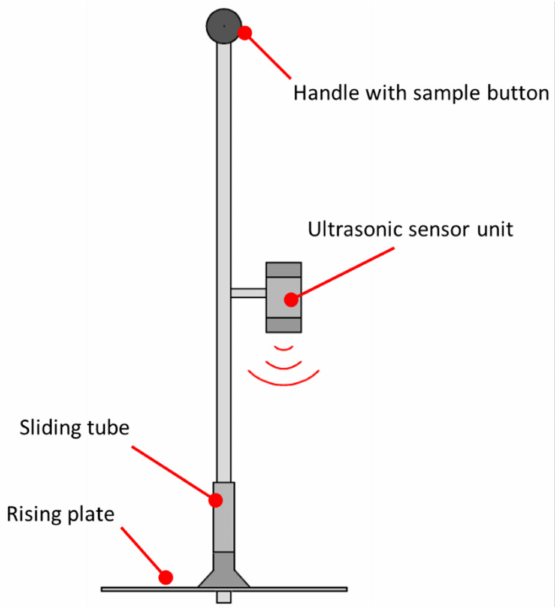
Figure 1. Schematic of ultrasonic rising plate meter developed by McSweeney et al.